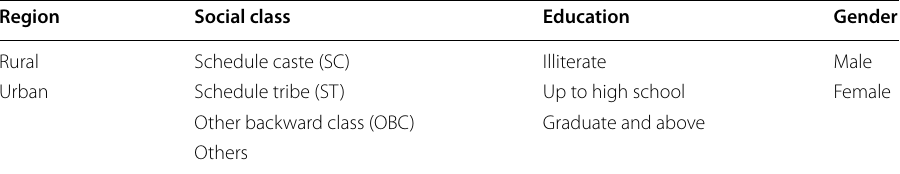
Table 2 Description of indicators to classify labour input Region Social class Education Gender Rural Schedule caste (SC) Illiterate Male Urban Graduate and Region (2) Social class (4) Education (3) Gender (2) 48 × × × =